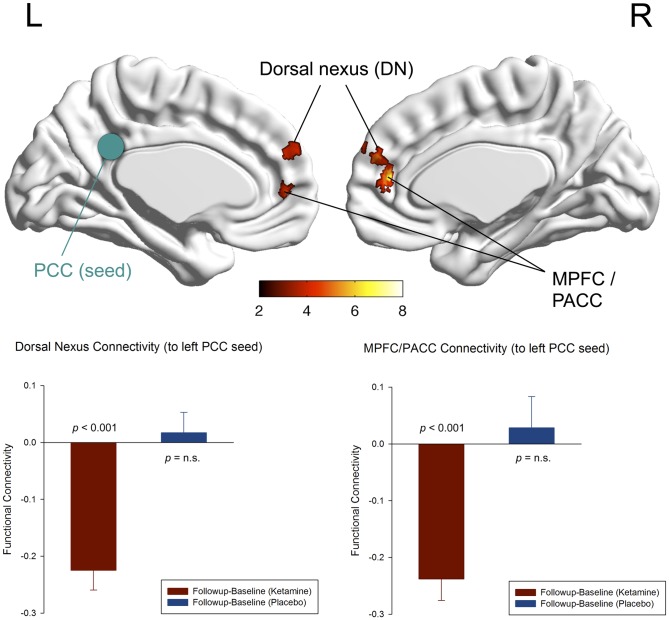
Functional connectivity of the default mode network (DMN).Significant voxels of the dorsal nexus (DMPFC) and pregenual anterior cingulate cortex (PACC) and medial prefrontal cortex (MPFC) showing reduced functional connectivity to the left posterior cingulate cortex (PCC) seed region (green) 24 hours after ketamine administration (n = 17, whole brain paired t-test: baseline(ketamine)-follow-up(ketamine); puncorr<0.001, extent threshold of k>15, corresponds to a cluster-level pcorr<0.05). The color bar indicates z values. The bar diagrams represent the change in functional connectivity (Fisher z-transformed correlation values) of the dorsal nexus (left) and the MPFC/PACC (right) to the left PCC from baseline to follow-up for the ketamine (red) and placebo condition (blue) (n = 17, paired t-test: p<0.001; error bars = s.e.m.).